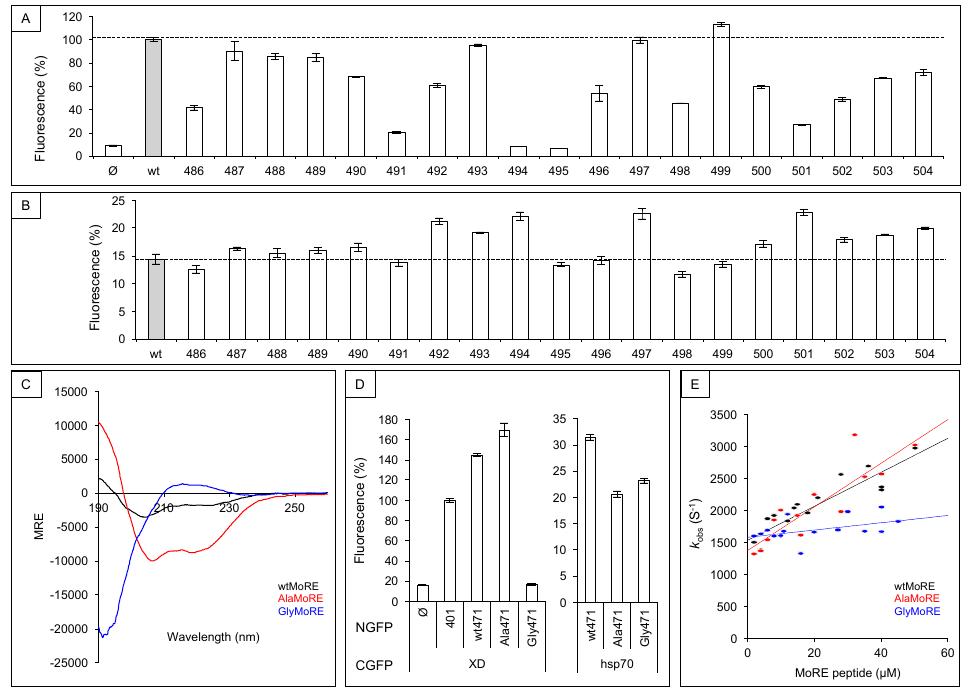
Figure 3. Effect of primary and secondary structures of the MoRE on XD and hsp70 binding. ( A , B ) Alanine scanning mutagenesis of N TAIL MoRE. MoRE residues (aa 486 to 504) of MeV N TAIL truncation variant 471 were individually mutated into an alanine (or a glycine when the wild-type residue was an alanine). The binding ability of each single N TAIL variant was then compared to that of wild-type N TAIL by split-GFP complementation assay using either XD ( A ) or hsp70 ( B ). Ø, negative control (fluorescence background obtained using an empty vector encoding NGFP alone); wt, positive control (i.e., wild-type truncation variant 471). Results are expressed as percentage with 100% being the fluorescence value provided by wt truncation variant 471. The horizontal dotted line indicates the binding of the positive control. ( C ) Far-UV circular dichroism spectra of wtMoRE, AlaMoRE, and GlyMoRE peptides. ( D ) Fluorescence values obtained by split-GFP complementation assays using N TAIL MoRE variants with different α -helicities. See A for details; 401, full-length wtN TAIL ; wt471, 471 truncated variant with a wtMoRE; Ala471, 471 truncated variant with AlaMoRE; Gly471, 471 truncated variant with GlyMoRE. ( E ) Binding kinetics of MoRE peptides to XD. Data shown in panels A, B, and D are the mean values and s.d. of an experiment performed in triplicate. Data were taken from [66].